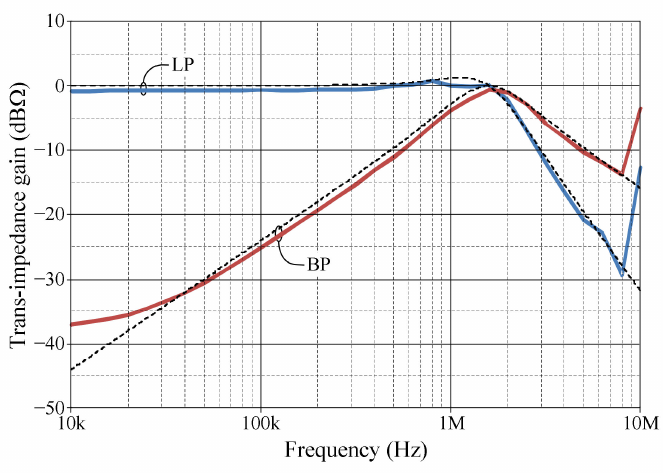
Figure 23. Ideal (dashed line) and measured (solid line) frequency responses for